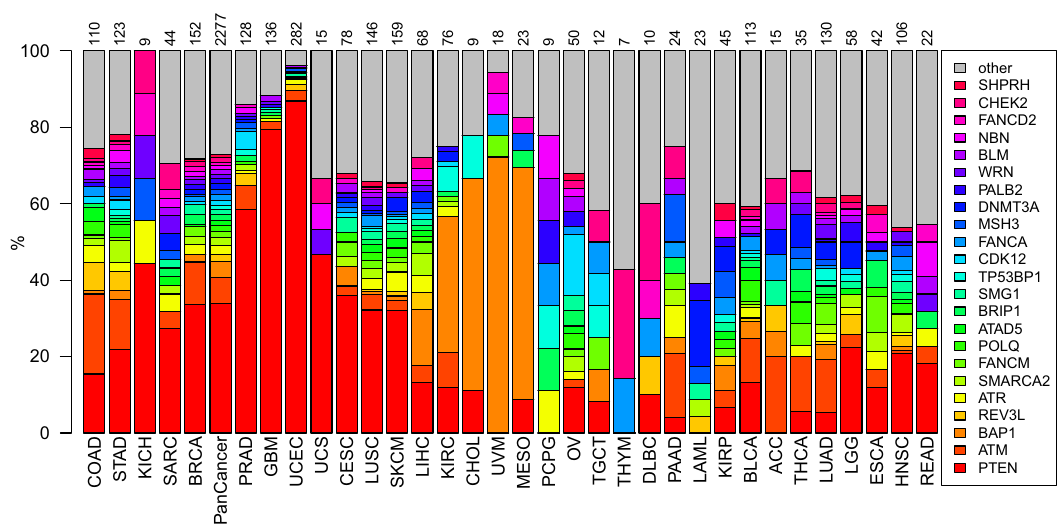
Fig. 3 In-depth analysis of the classes H1a (tumors with deleterious BRCA1/2 alterations) and H1b (tumors with deleterious alterations in other HRR genes). a Splitting of the deleterious BRCA1/2 alterations with respect to mutation type and the number of affected alleles. BA biallelic alteration, MA monoallelic alteration. b Splitting of the HHR gene alterations with respect to the affected